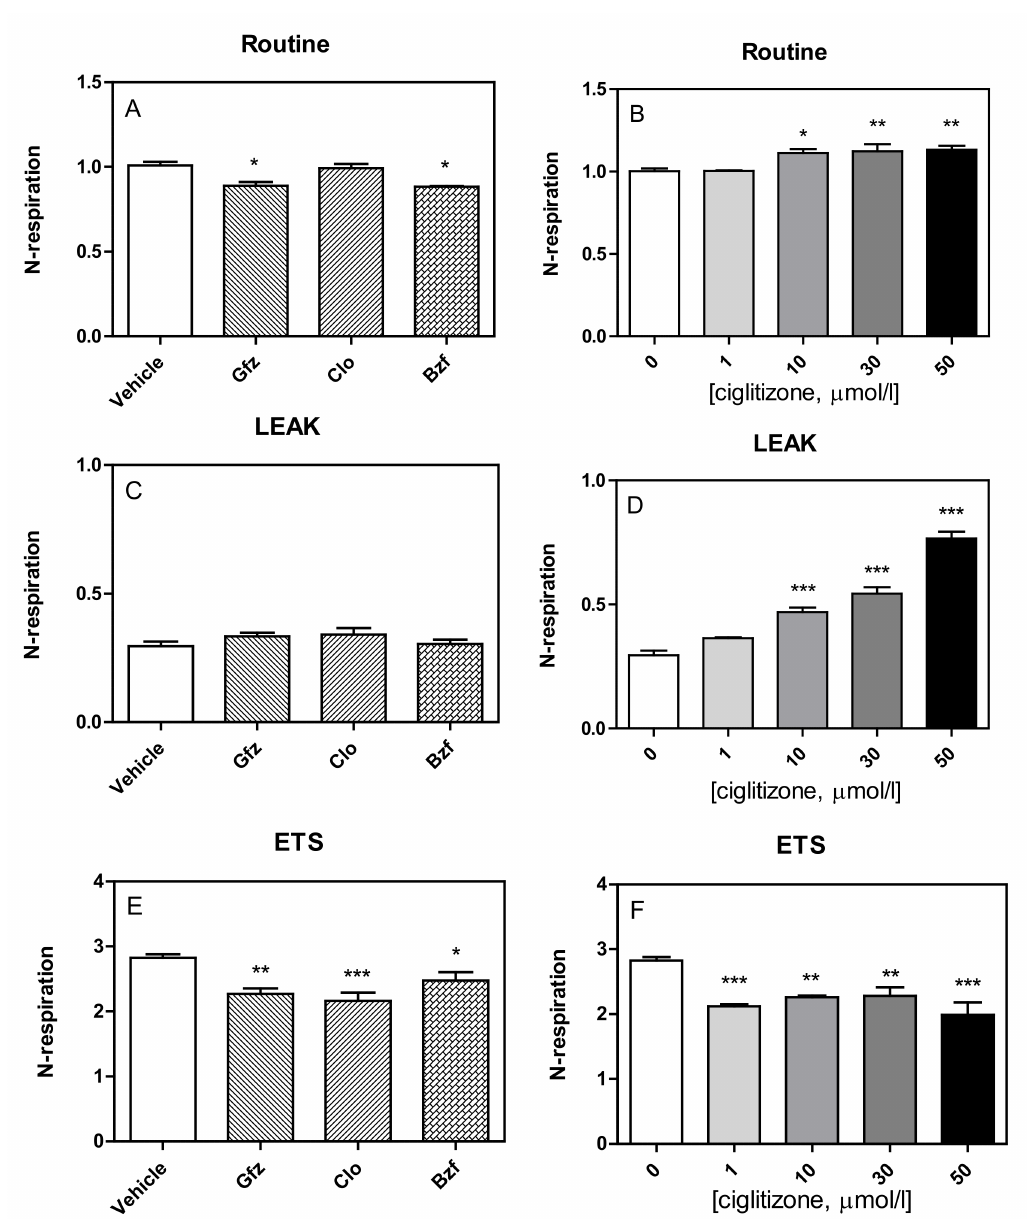
Figure 4. The effect of PPAR ligands (on the left) and increasing concentrations of ciglitizone (on the right) on the respiratory states in HepG2 cells. Cellular respiration, calculated as the oxygen flux, ROX-corrected, normalized to the respective basal rate) was evaluated at different stages: Routine (Panel A , B ), Leak (Panel C , D ), ETS (Panel E , F ). Data show the mean ± SEM of three experiments in duplicate, analyzed by ANOVA, using Dunnett multiple comparison test to calculate significance (* p < 0.05, ** p < 0.01, and *** p <